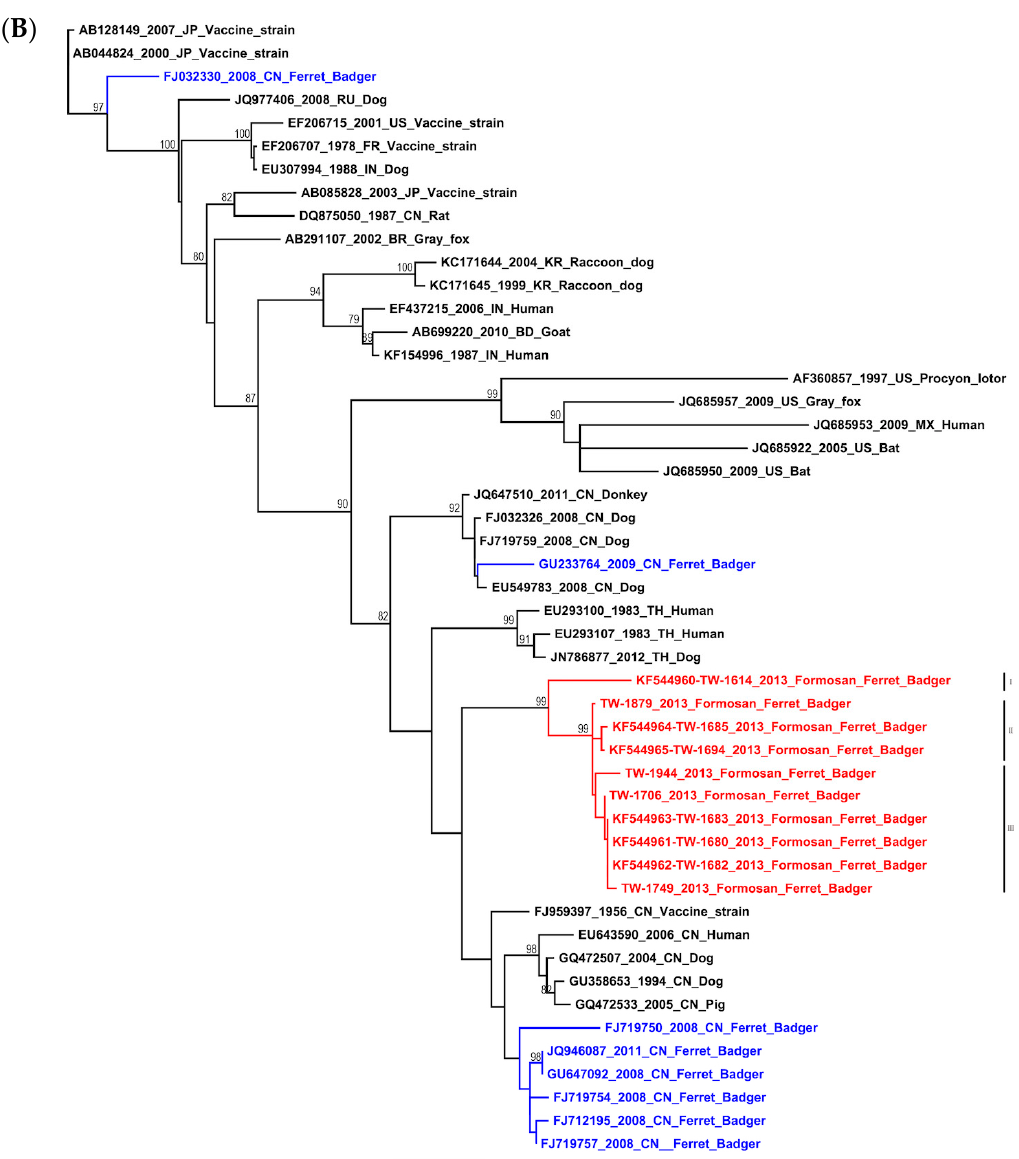
Figure 1. Cont. Figure 1.